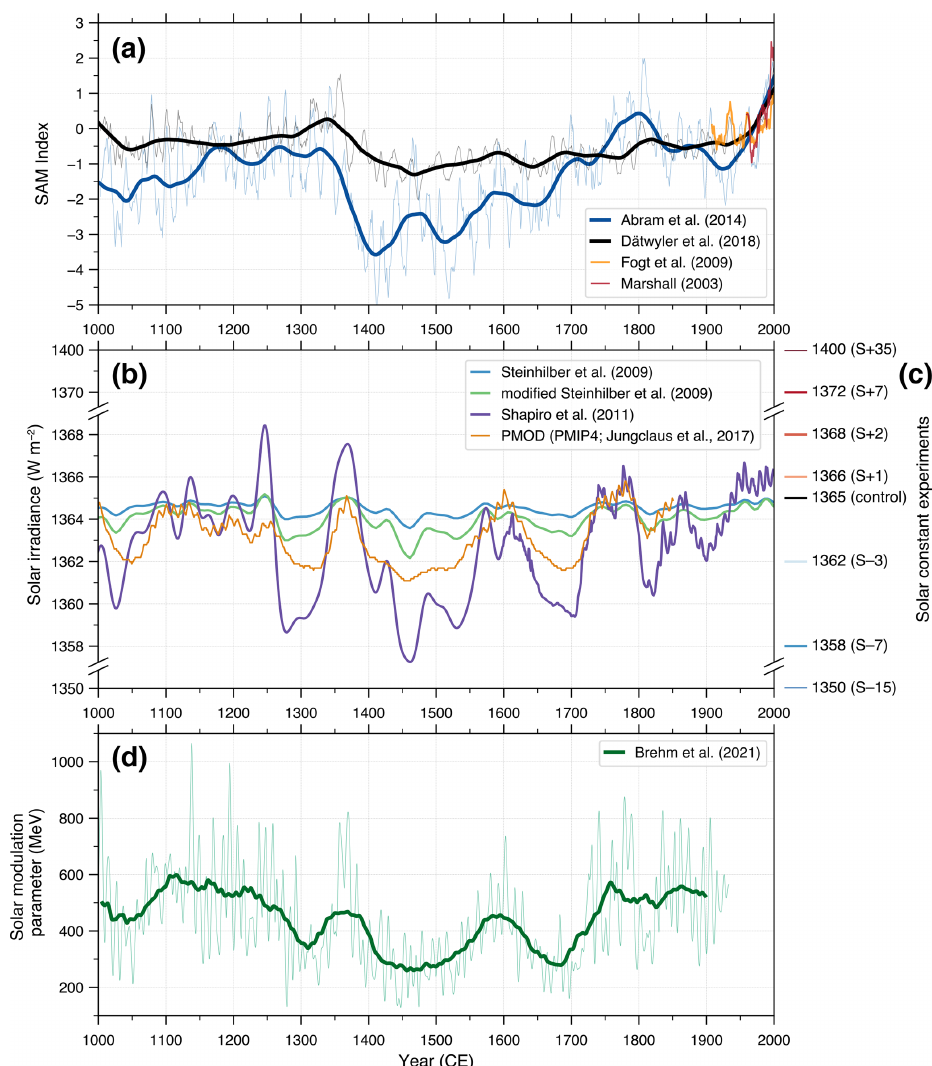
Figure 1. Reconstructed SAM and solar variability over the last millennium. (a) Observation-based mean annual SAM indices (normalised units) of Marshall (2003) (red) and Fogt et al. (2009) (orange) and the reconstructed SAM index of Abram et al. (2014) (A14, blue) and Dätwyler et al. (2018) (D18, black; see Sect. 2.1 for an explanation of the difference in magnitude between the SAM reconstructions). The reconstructions are plotted as a 7-year moving average for the annual SAM index (thin lines) with a 70-year LOESS filter (thick lines), while 7-year moving averages are shown for the observational data. (b) Total solar irradiance reconstructions for the last millennium, including Steinhilber et al. (2009) (blue) and a modified version of Steinhilber et al. (2009) (green), where the amplitude of the variations relative to the long-term mean has been increased by a factor of 2 and Shapiro et al. (2011) (purple). For comparison with the current high-amplitude scenario, we also include the PMOD reconstruction from PMIP4 (Jungclaus et al., 2017) (orange). Note that PMOD has been normalised to 1365Wm − 2 to be comparable to the other solar reconstructions presented here. (c) Solar irradiance values for our solar constant experiments, with the experiment name provided in parentheses. (d) Solar modulation parameter reconstruction for the last millennium based on radiocarbon from annually resolved and dated tree rings (Brehm et al., 2021) and shown as monthly resolution (thin lines) and a 70-year moving average (thick